Question: Identify the chart type used in this figure.
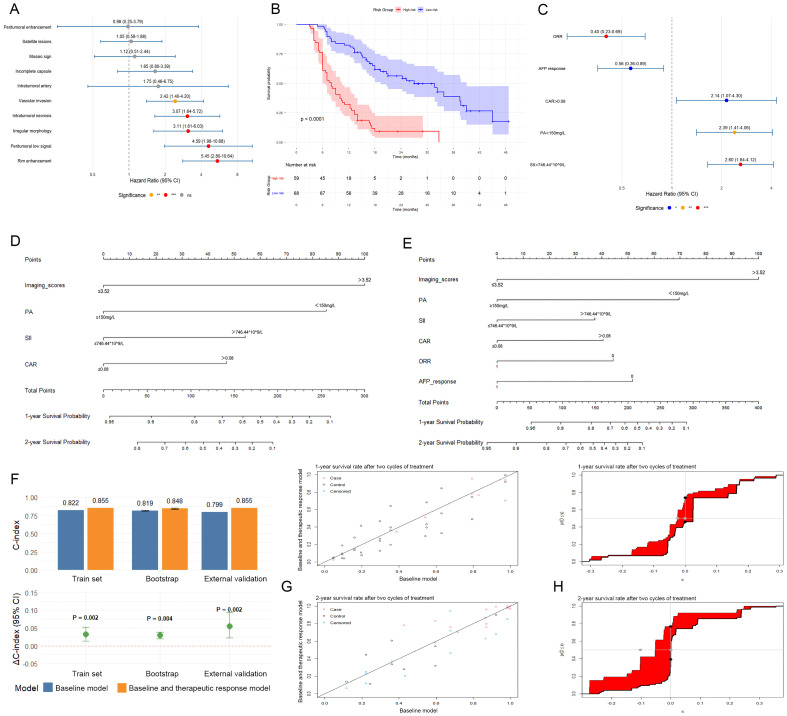
Answer: forest